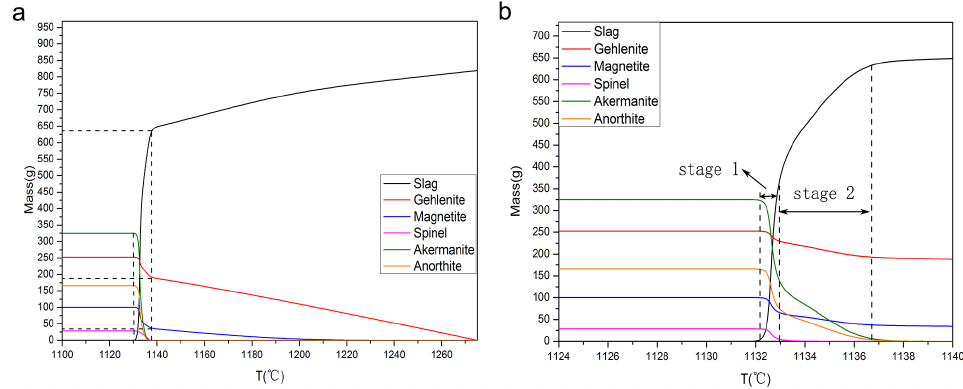
Figure 9. Masses of gehlenite, merwinite, magnetite, spinel, akermanite, anorthite, and slag at each thermodynamic equilibrium state (G30D70): ( a ) 1100 °C to 1275 °C; ( b ) 1124 °C to 1140